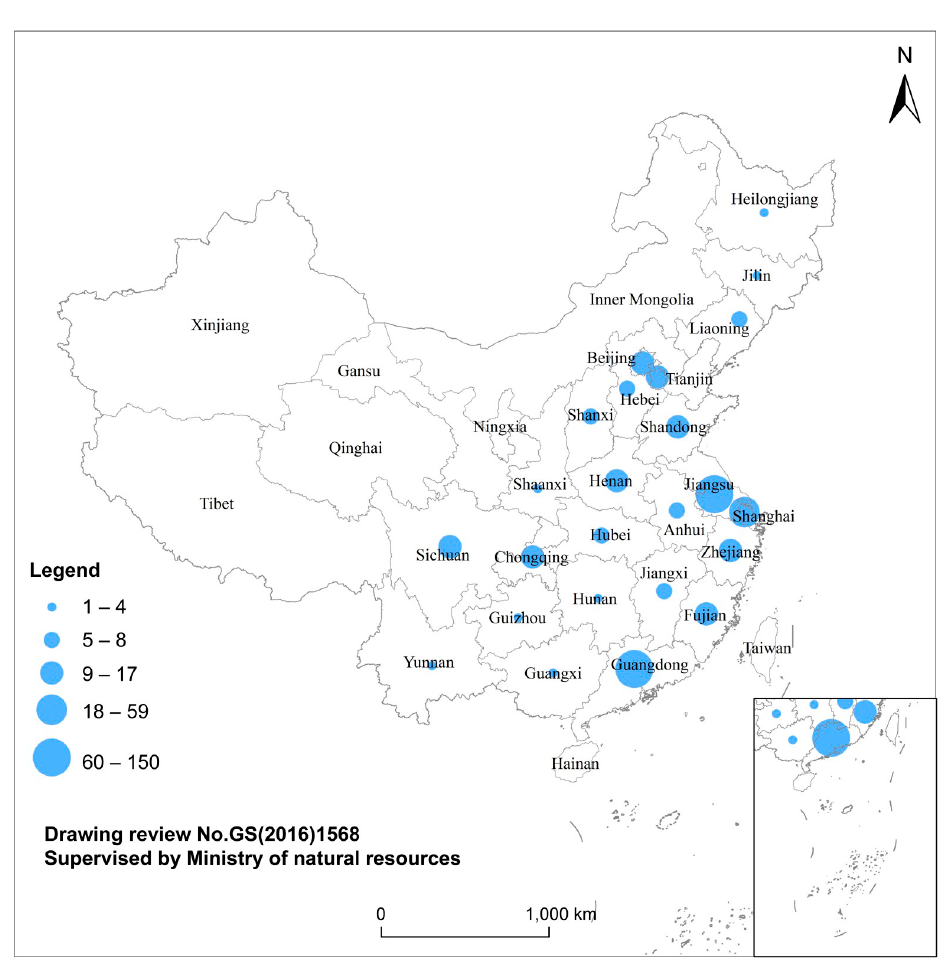
Fig 6. Spatial layout of Taiwanese-listed OTC electronic information enterprises in Mainland China.